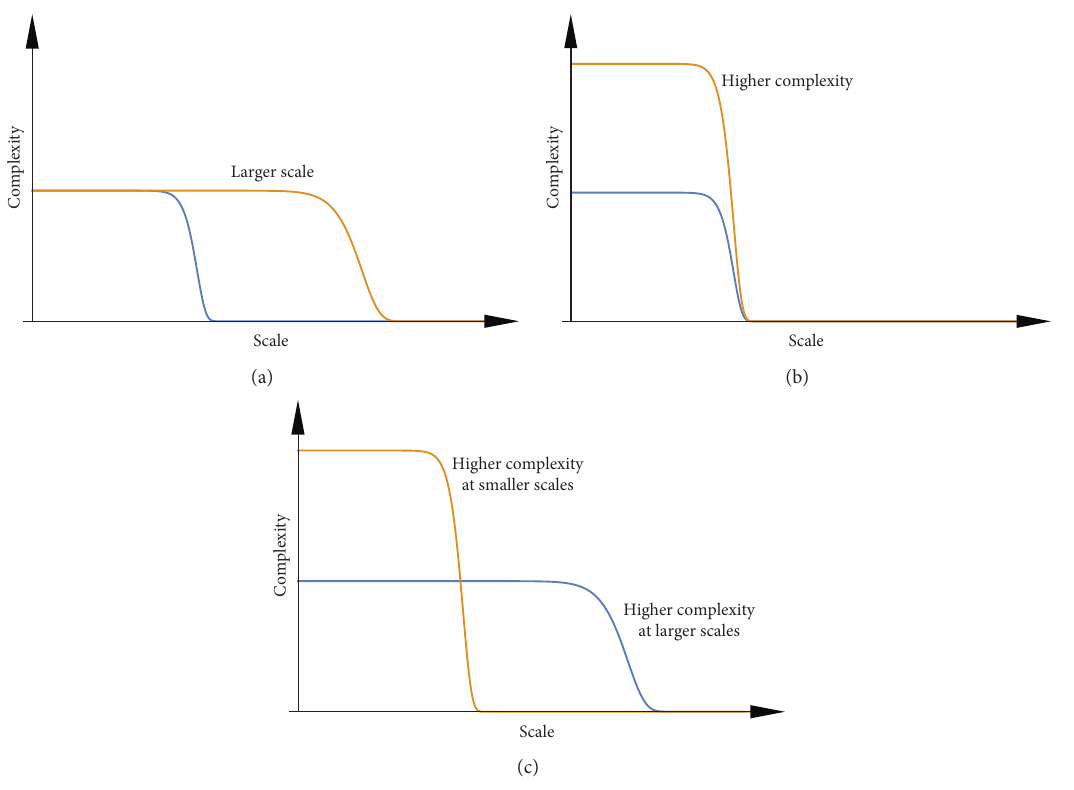
Figure 4: Schematic complexity profiles of militaries in conflict. (a) If two armies are operating with the same number of possible behaviors but at different scales, the larger-scale one is favored. (b) If two armies are operating at the same scale but with different numbers of possible behaviors, the higher-complexity one is favored. (c) If two armies are operating at different scales and with different numbers of possible behaviors, which one is favored depends on the terrain (see text). Note that these profiles are simplified to highlight the key concepts; actual militaries operate at multiple scales. More generally, (a) and (b) depict conflicts in which one army has at least as much complexity as the other at every